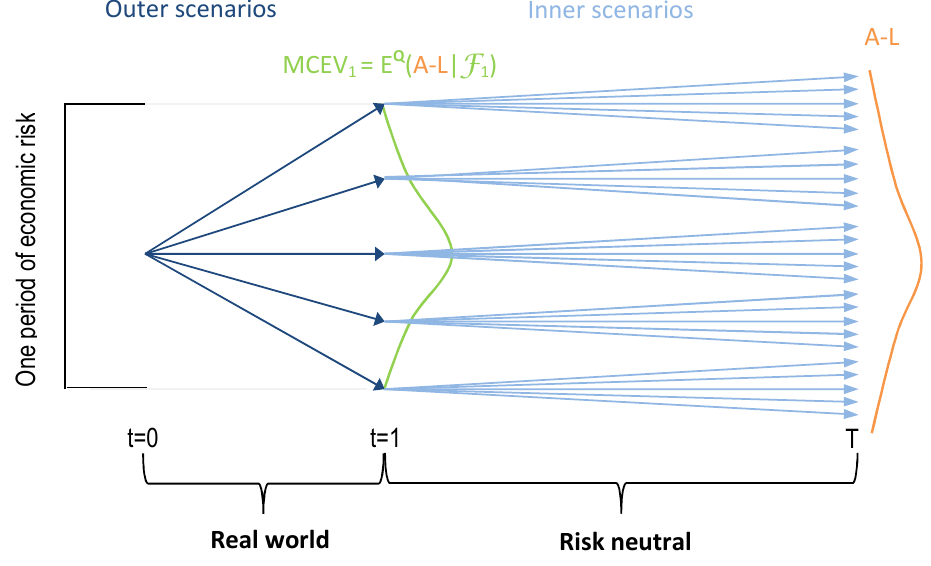
Figure 1. Replicating portfolio approach: Each node at t = 1 and t = T represents a state of the portfolio and liabilities. The target is to estimate the 99.5% quantile of the market consistent embedded value (MCEV) distribution at t =